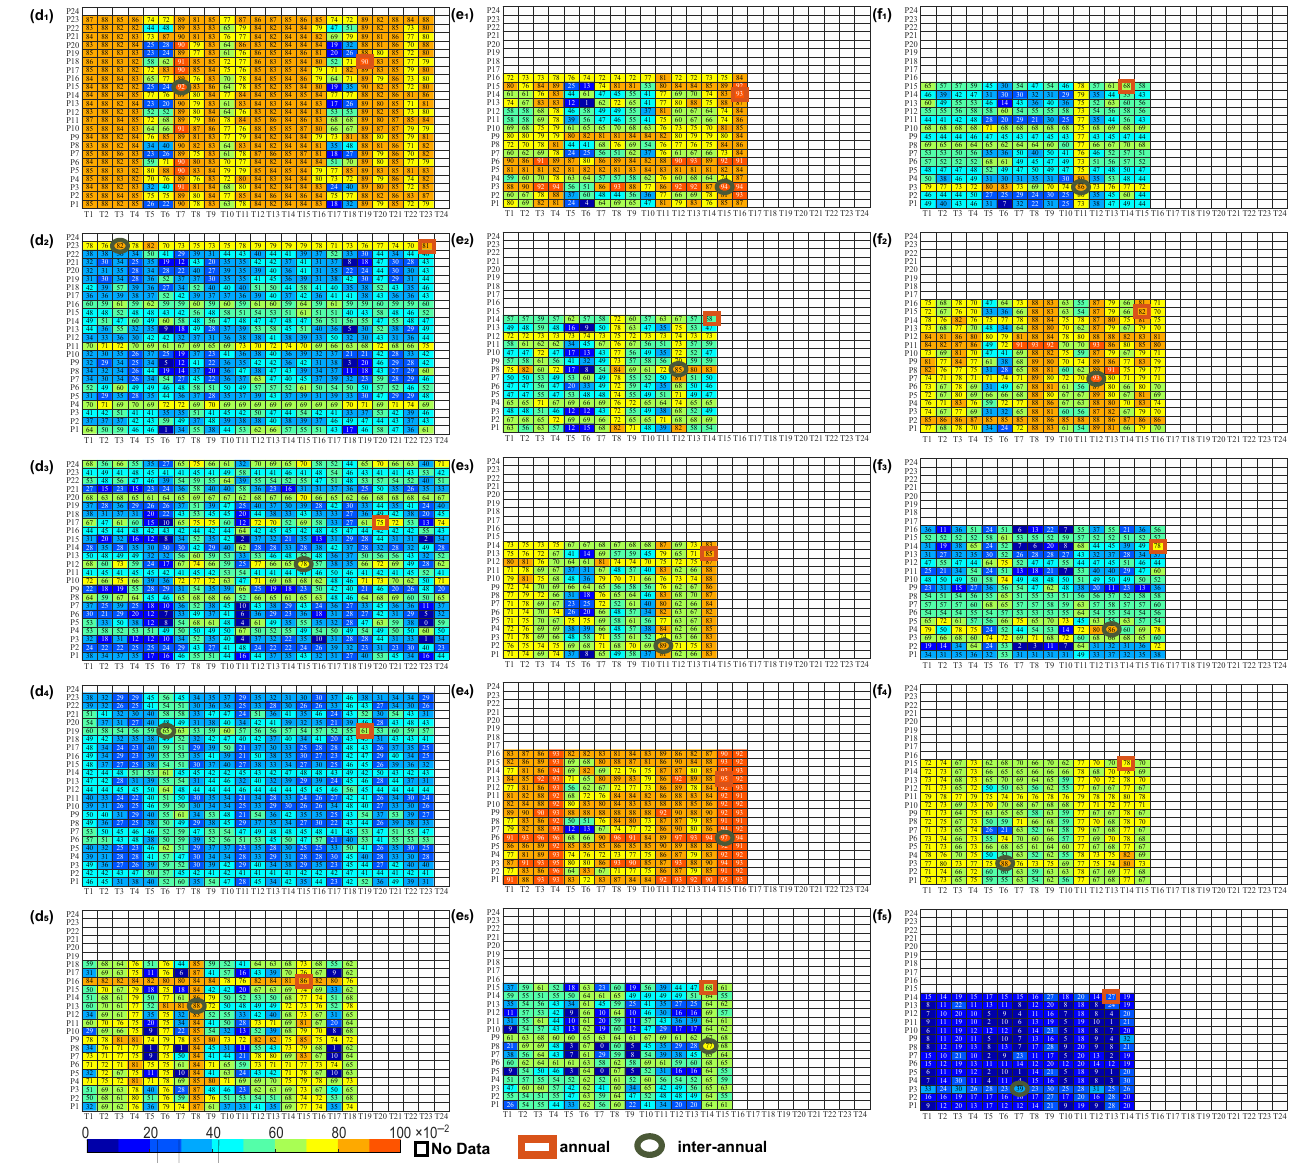
Figure 3. Time delay effects of multiple combinations of climate factors over the 15-year periods on vegetation. The numbers 1–24 represent the corresponding months, in which 1–12 represent January to December of the previous year, and 13–24 represent January to December of the current year, where T 1 , T 2 , . . . , T 24 and P 1 , P 2 , . . . , P 24 represent the corresponding months of temperature and